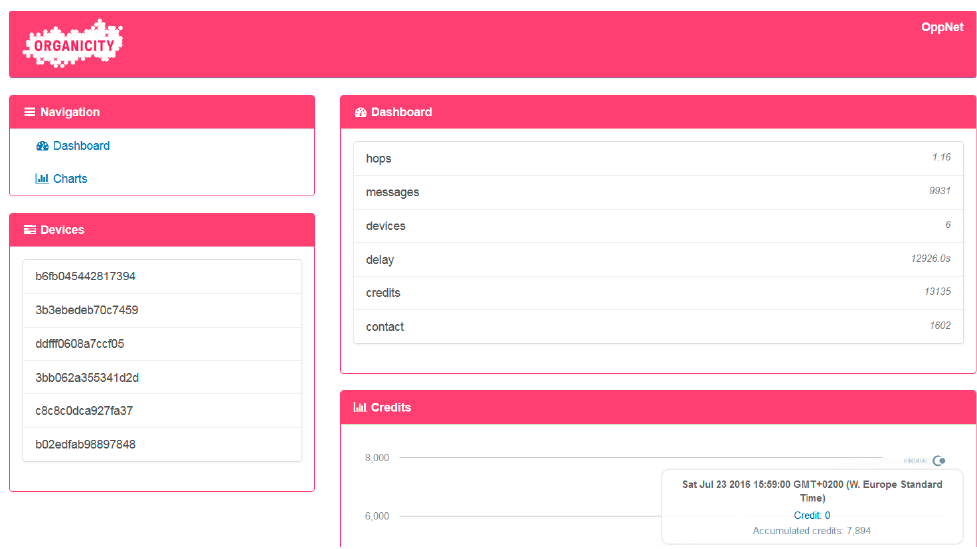
Figure 14. Screenshots of the OppNet visualization server.